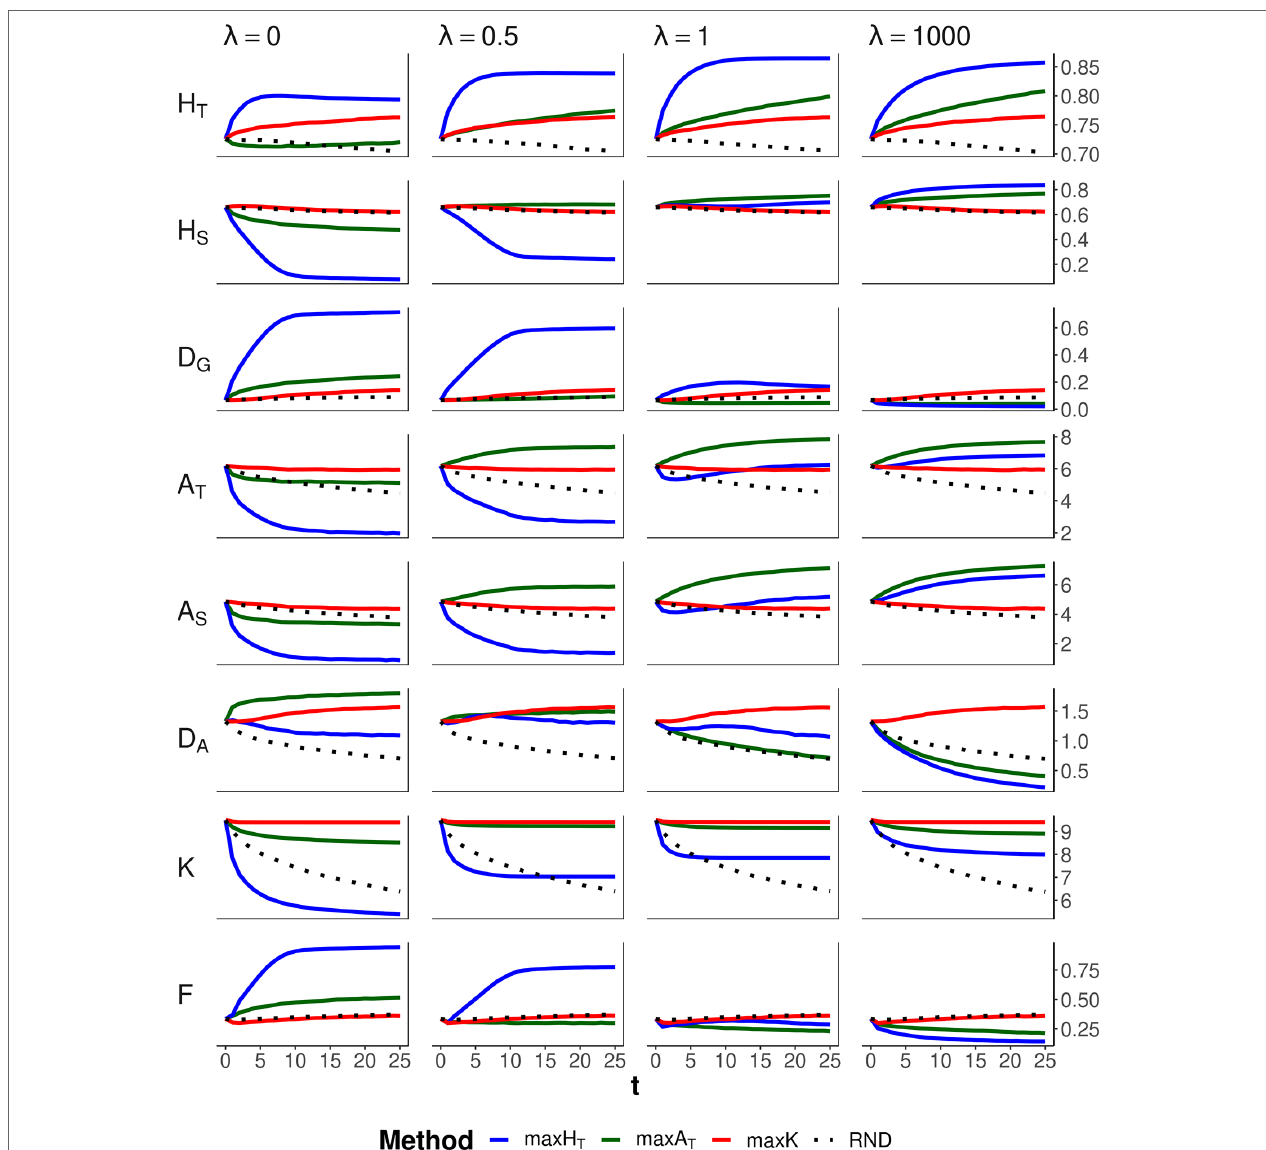
FIGURE 4 | Changes in different diversity parameters over generations ( t ) in a subdivided population subjected to three optimization methods, maxH T (blue line), maxA T (green line), and maxK (red line), and an unmanaged control (RND, dotted black line). Optimization was made for a particular set of loci (12 multiallelic single-nucleotide polymorphism haplotype markers). In the case of maxH T and maxA T , different between-population weighting factors ( λ ) were assumed. One migrant per subpopulation and generation was considered in the optimizations. Statistics refer to the managed markers: total heterozygosity ( H T ) and its within- and between-subpopulation components ( H S and D G ); total allelic diversity ( A T ) and its within- and between-subpopulation components ( A S and D A ); total number of alleles in the population ( K ); and average coefficient of molecular inbreeding of individuals ( F ). Standard errors for means are lower than 0.01 (allelic measures), 0.001 (heterozygosity measures), and 0.002 ( F